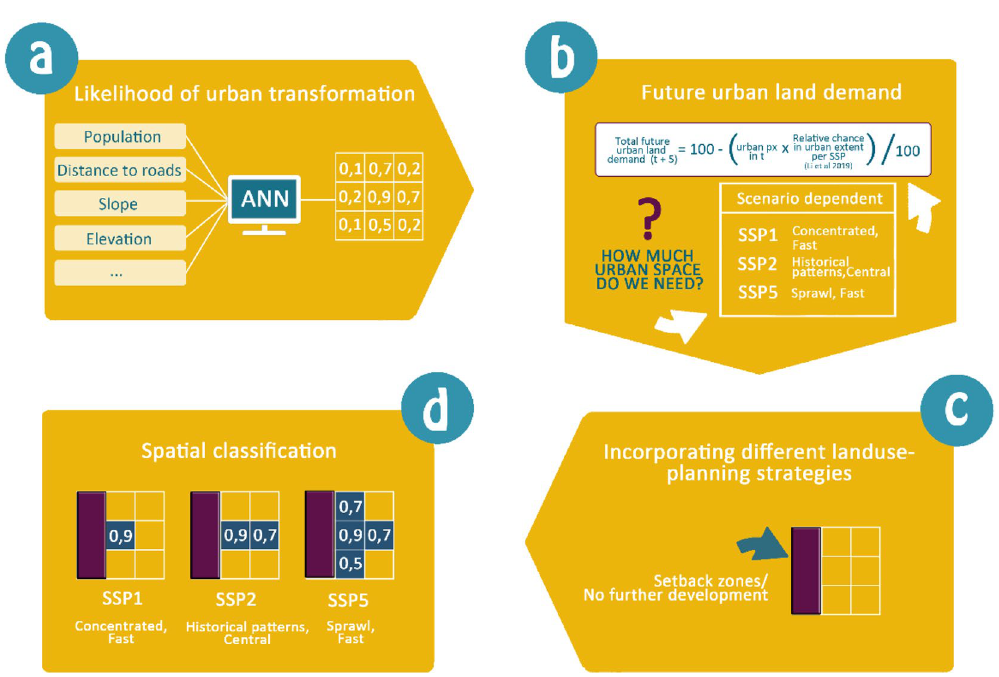
Figure 10. Urban change modelling chain. Step ( a ) visualizes the use of the MLP ANN to develop the urban development potential/likelihood surface; Step ( b ) shows the calculation of the future demand for urban land; Step ( c ) illustrates the incorporation of different setback zone scenarios, and in Step ( d ) the final spatial reclassification to generate the spatially-explicit projections is